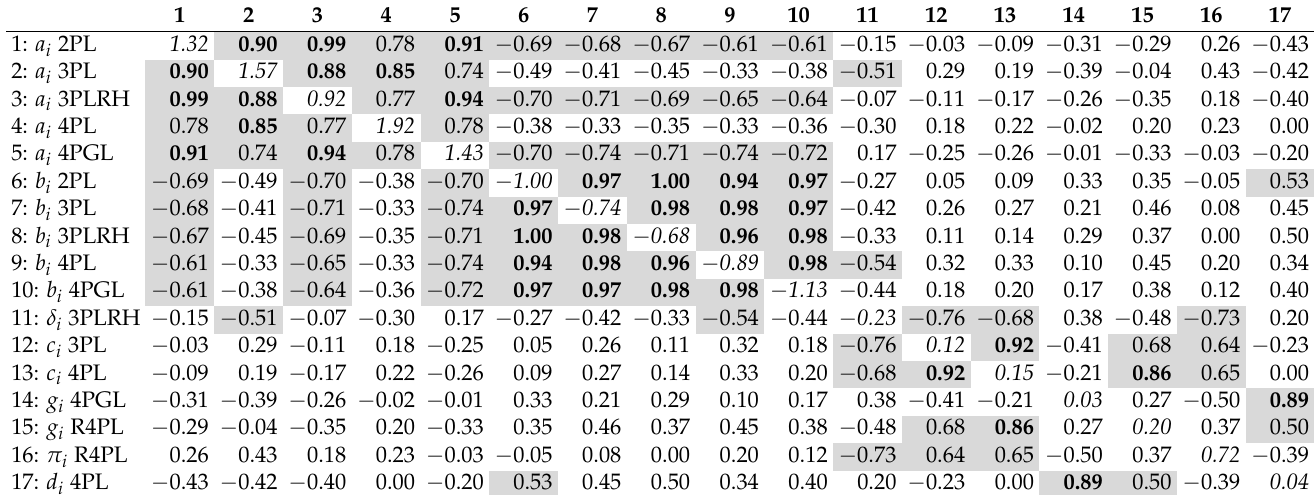
Table 6. PIRLS 2016 reading: Means (diagonal entries) and correlations (non-diagonal entries) of estimated item parameters of multiple-choice items in different scaling